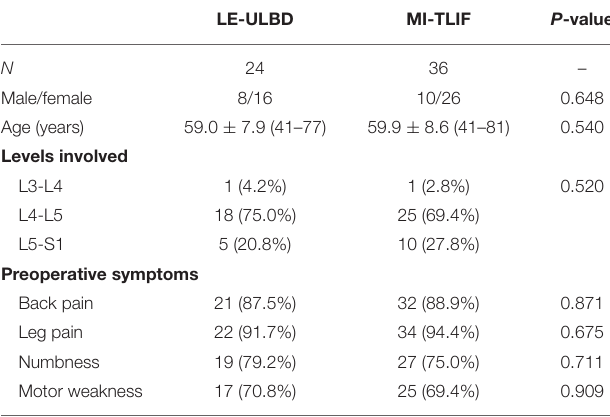
TABLE 1 | Baseline characteristics of the two groups.